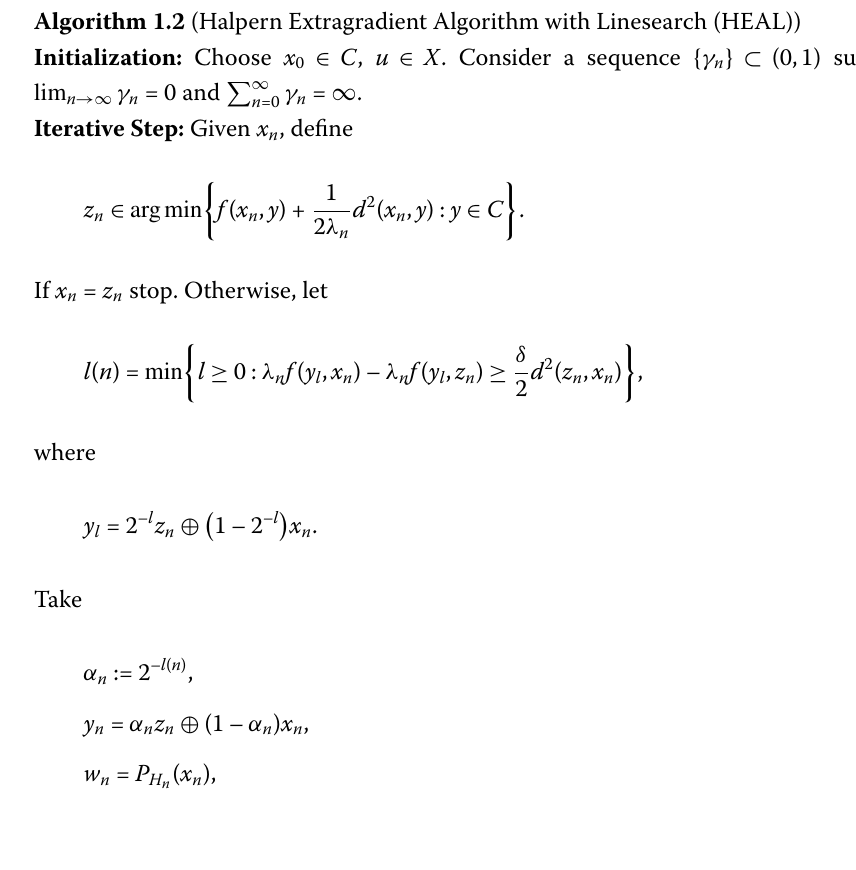
Algorithm 1.2 (Halpern Extragradient Algorithm with Linesearch